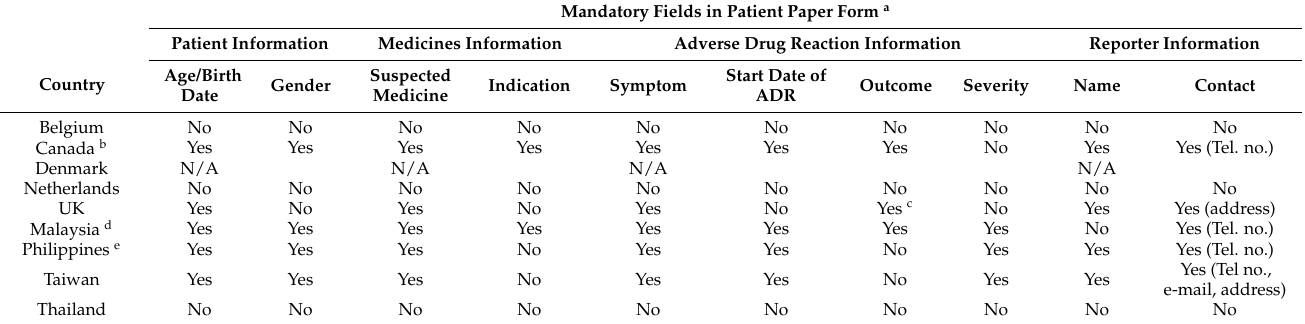
Table 6. Characteristics of patient paper